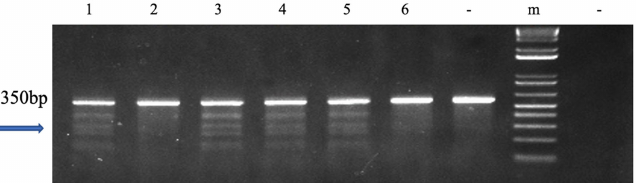
Figure 1. Surveyor mutation detection test results of P 1 channel catfish ( Ictalurus punctatus ). The mutation was targeted at the follicle ‐ stimulating hormone ( fsh ) gene. The “ ‐ ” on the left of the mo ‐ lecular marker indicates the control, which is wild ‐ type fish DNA. The right “ ‐ ” denotes the negative control using water as the DNA template; “m” indicates 1 kb molecular marker. Mutated channel catfish are shown in lanes 1, 3, 4, and 5, and wild ‐ type channel catfish are displayed in lanes 2 and 6. Figure 1 was derived from the full ‐ length gel shown in Supplementary Figure S2. The mutation of the fsh gene in channel catfish was validated by sequencing and se ‐ quence comparison. All the modifications happened within the TALEN cutting region. In the coding area of the fsh gene, we found distinct mutation types, including substitutions, base deletions, and insertions, which determines the biological responsiveness of the hor ‐ mone (Figure 2A). The fsh gene’s product is expected to be affected by these mutations, which are also expected to prevent the gene from functioning properly (Figure 2B). We compared these five frame shift mutations with that of the known normal human fsh gene structure; four of five resulted in losing of the N ‐ glycosylation site, which acts as the at ‐ taching site for oligosaccharides to bind and then assembly subunit and dimerization af ‐ terwards. Therefore, in silico analysis indicates the protein structures might be destroyed and the biological function of fsh may be reduced or eliminated (Figure 2C). The correct assembly of the subunit determined the metabolic clearance of the gonadotrophin.